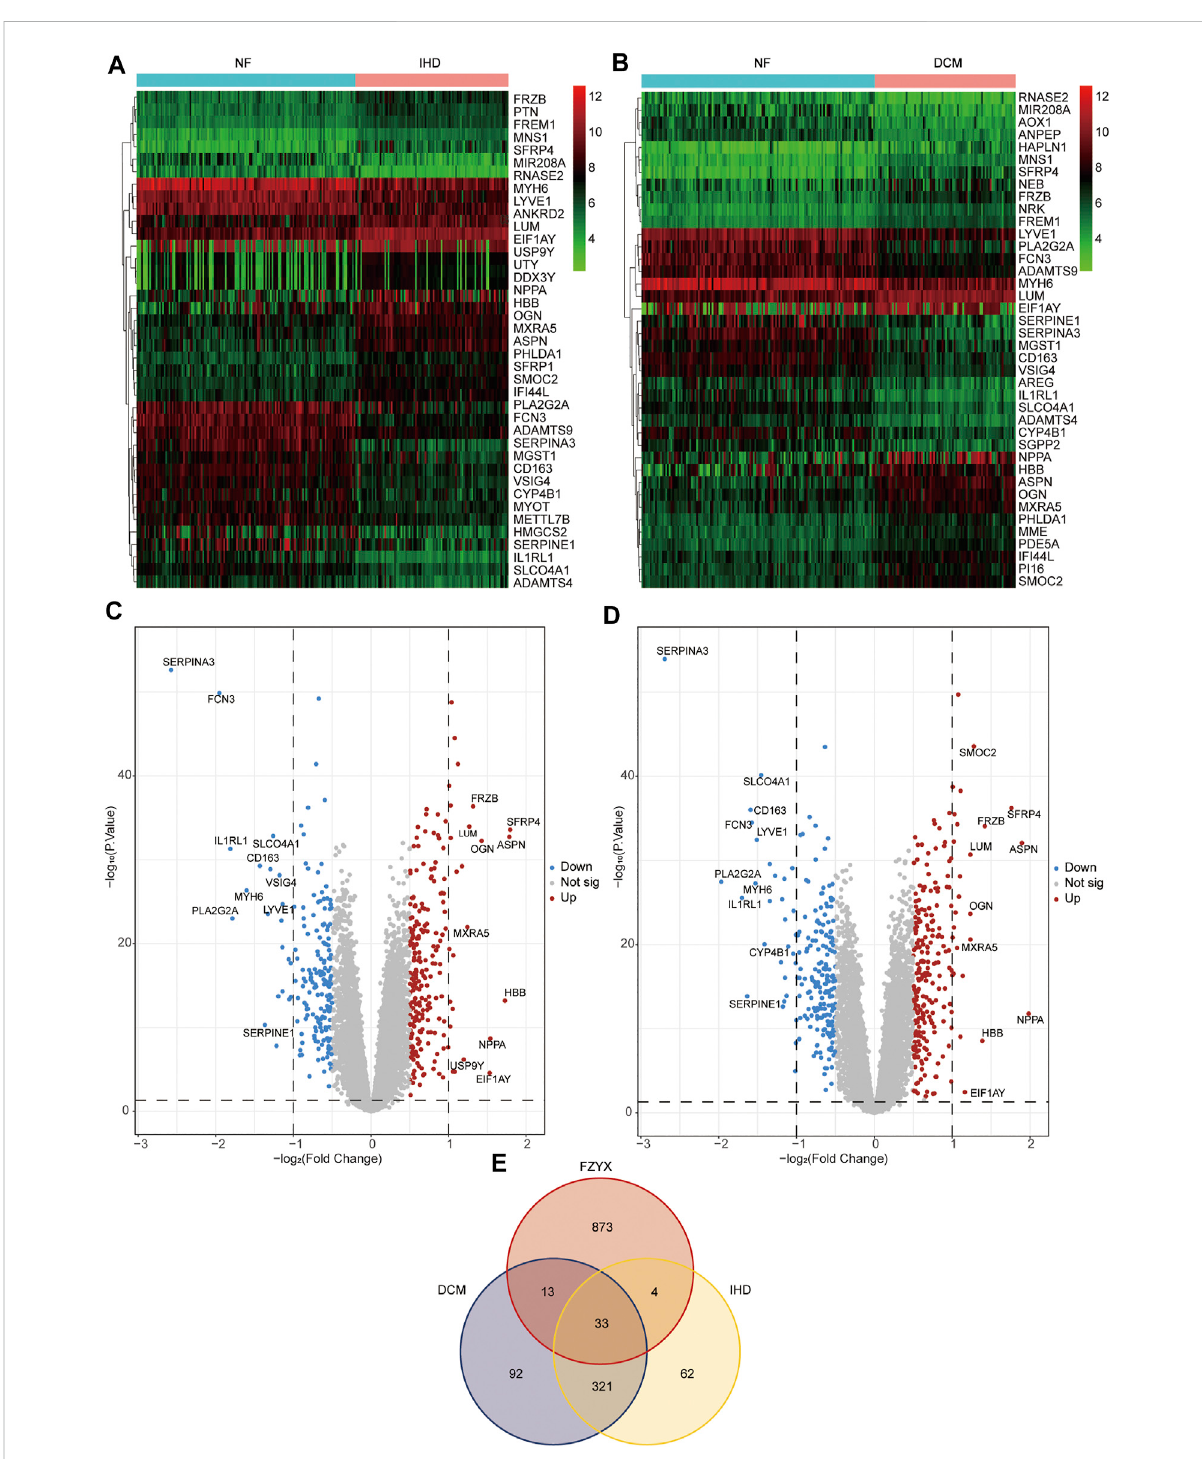
FIGURE 1 Differential gene acquisition and network construction. (A) Heatmap of non-failing (NF) VS ischemic heart disease (IHD). Green represents low expression, black represents medium expression, and red represents high expression. (B) Heatmap of NF VS idiopathic dilated cardiomyopathy (DCM). Green represents low expression, black represents medium expression, and red represents high expression. (C) Volcano map of IHD. (D) Volcano map of DCM. (E) Venn diagram of FZYX, IHD and